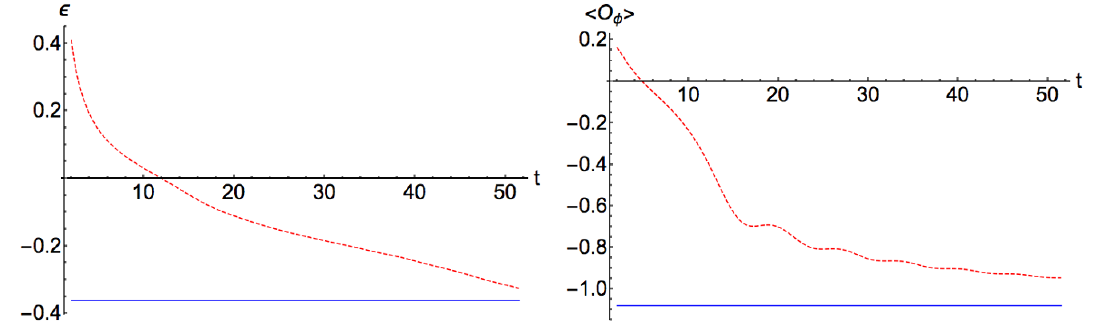
Figure 15 . The energy (left) and expectation value of the operator dual to the scalar (cid:12)eld (right) as a function of time in boost invariant (cid:13)ow for the class C potential. The horizontal blue lines correspond to the black hole with lowest energy